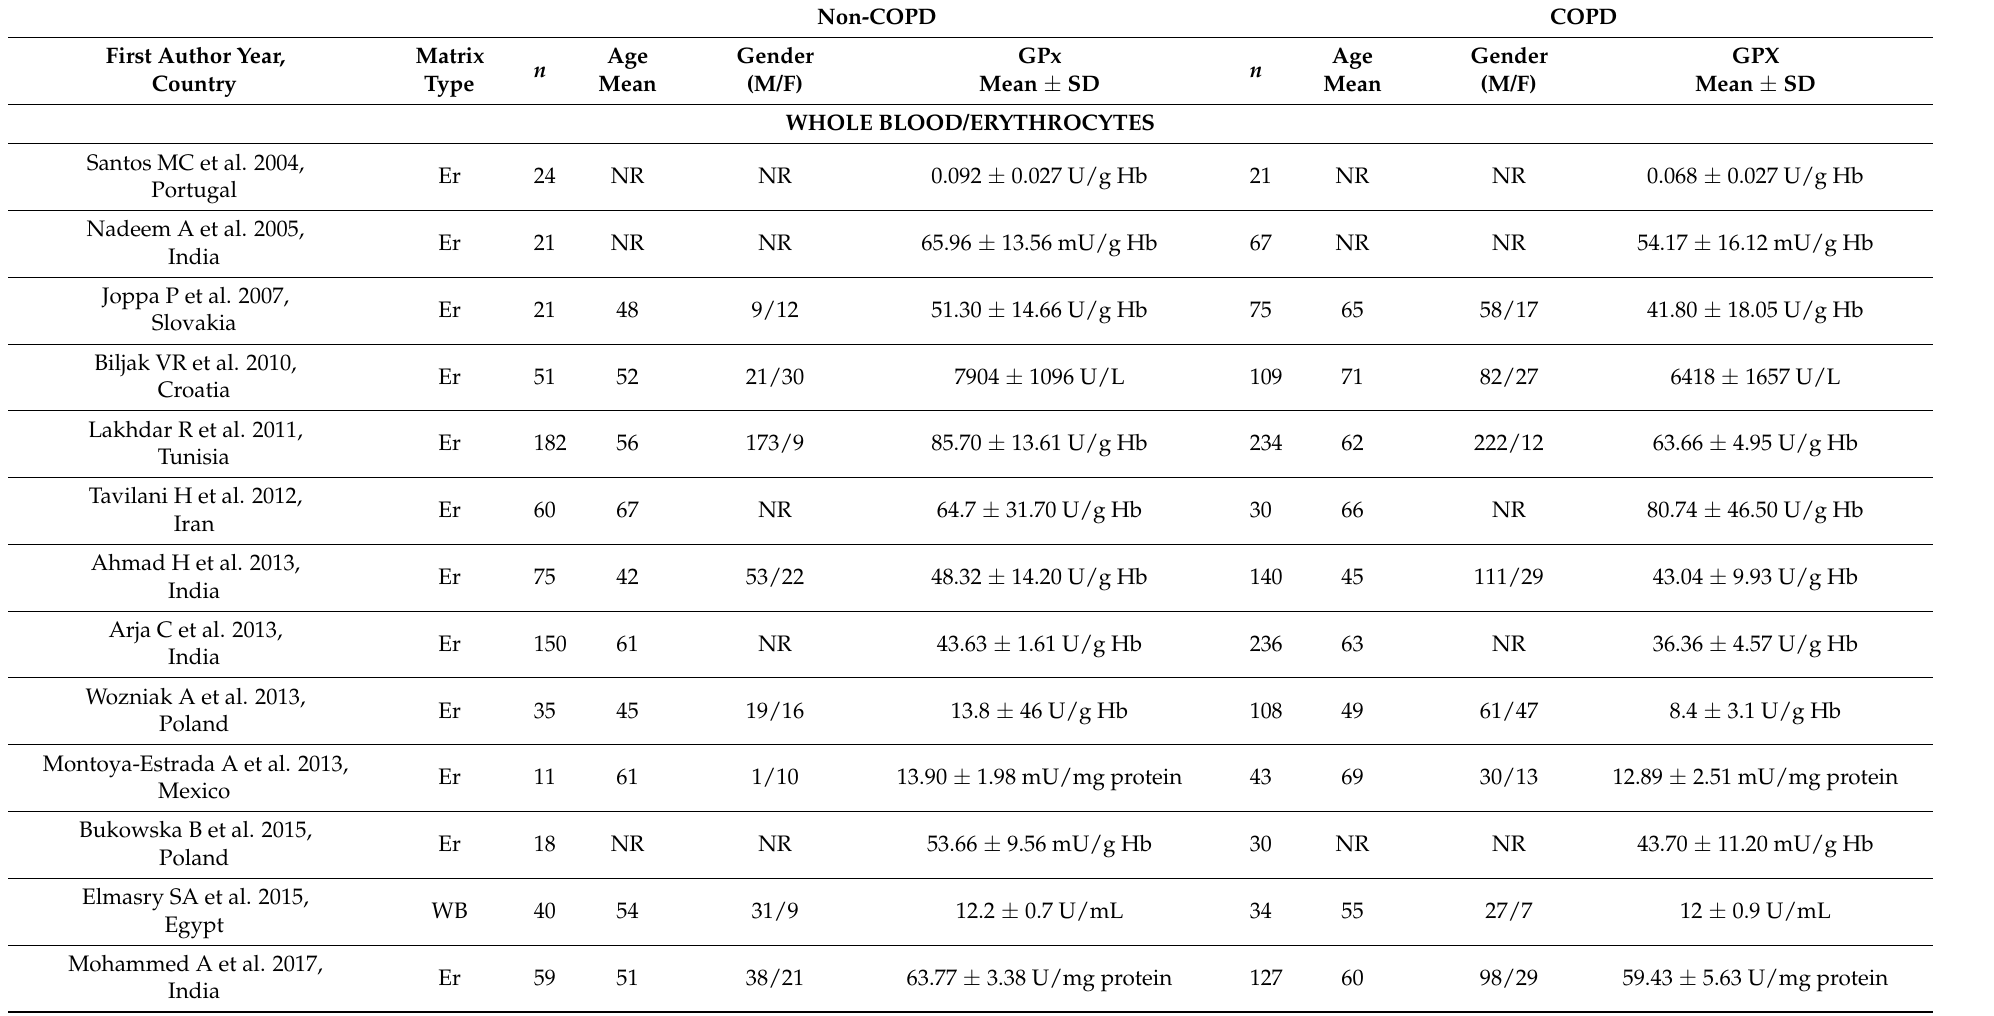
Table 1. Summary of the studies on non-COPD subjects vs COPD patients included in the meta-analysis. Non-COPD